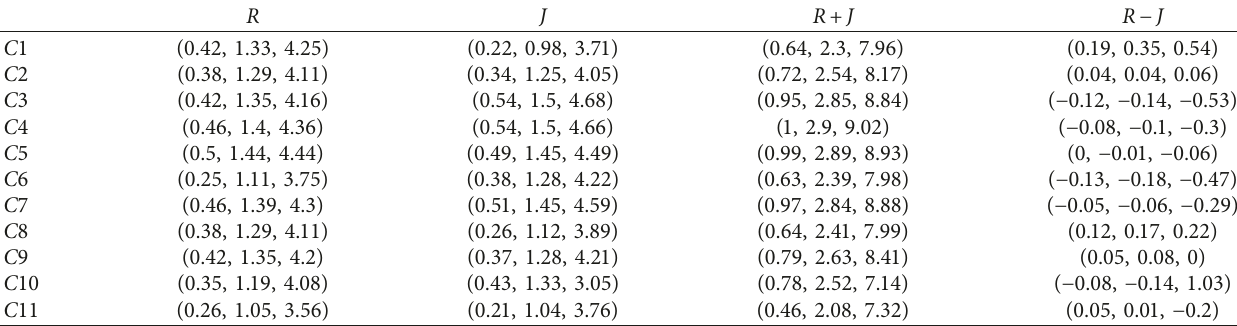
Table 5: Values ( J ), ( R ), ( R + J ), and ( R − J ) in a fuzzy form.